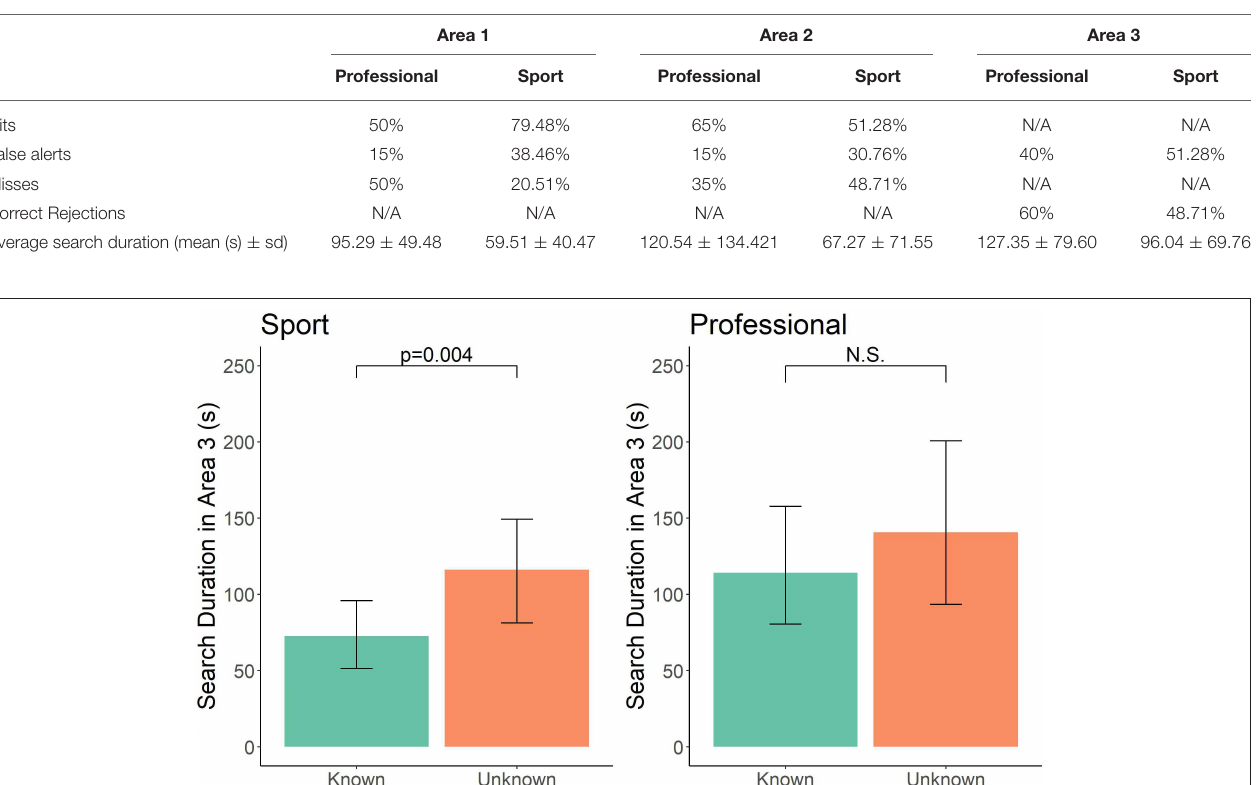
the duration of the search between hits and false alerts. Sport- handler dog teams that false alerted, had on average, searched for 19.70 s longer than when the average hit was called ( t = − 2.682,